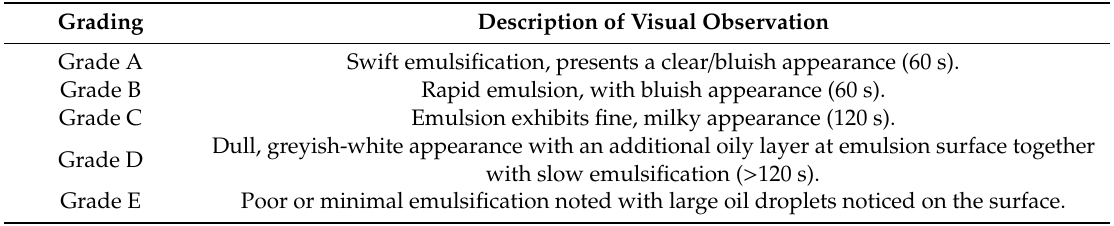
Table 1. Grading system of spontaneous